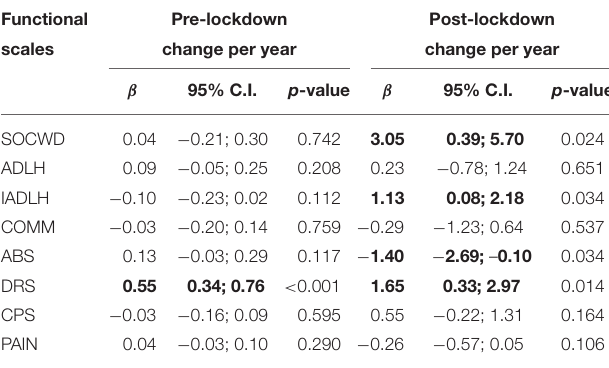
TABLE 3 | Rate of change ( β and 95% C.I.) over time of physical and mental health scales before and after the lockdown. Functional